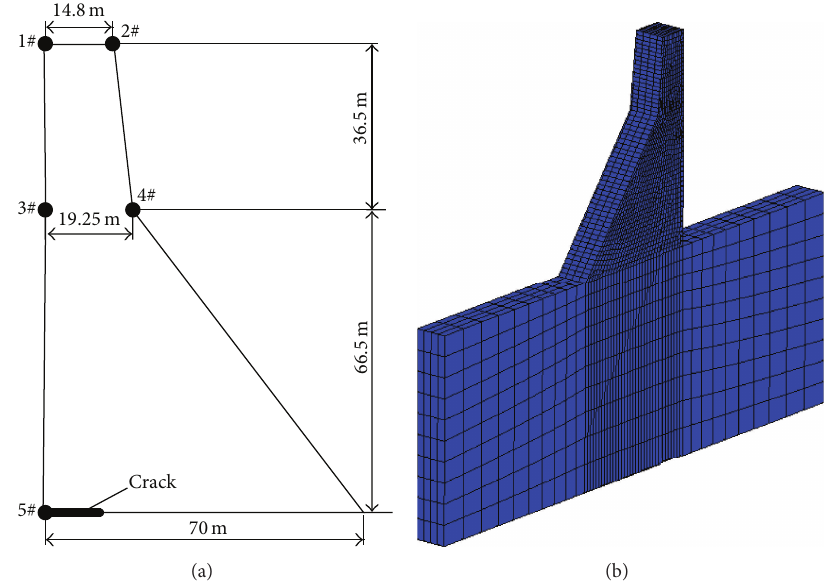
Figure 4: The numerical model, (a) the model size, and (b) the finite element model.